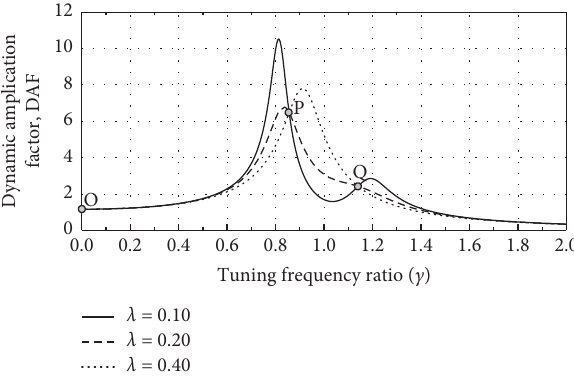
Figure 3: DAF curves of undamped primary system with μ � 0.1, β � 1.1, and θ � −